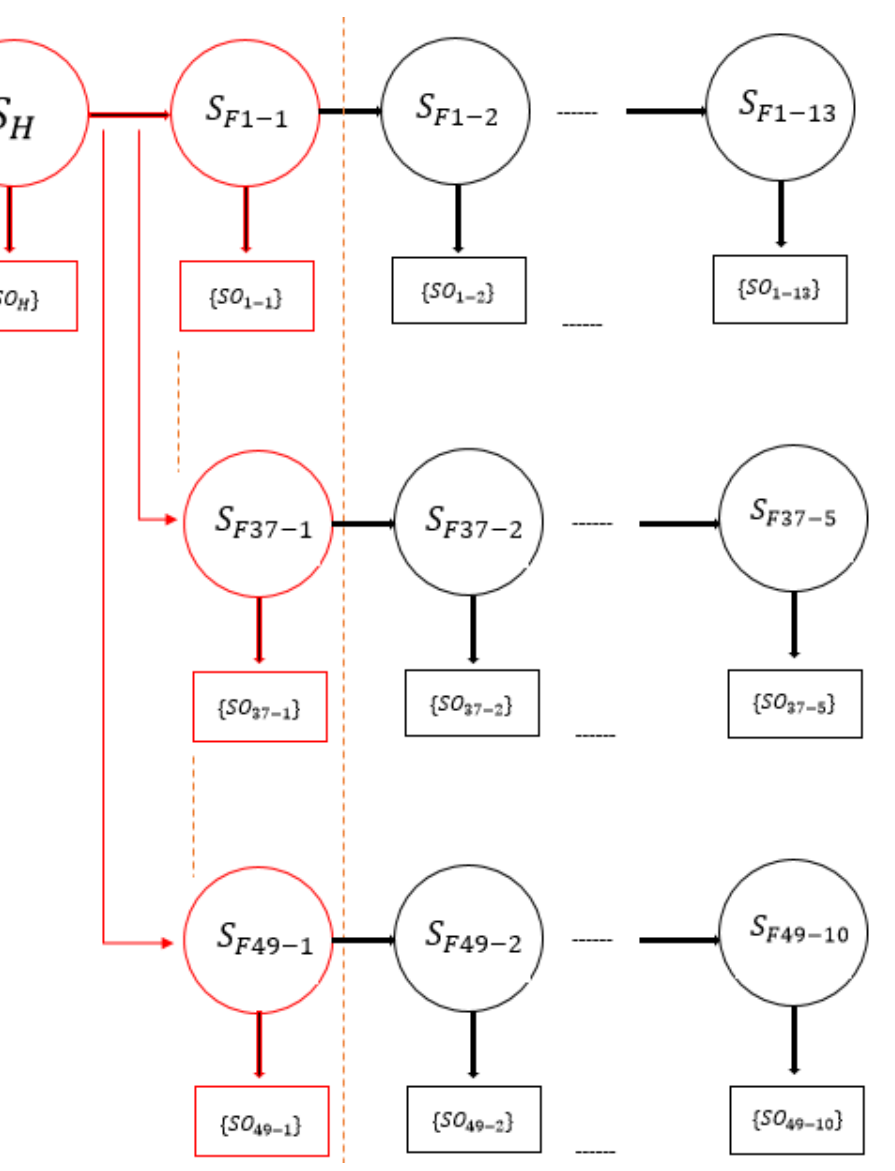
Figure 20. Multi-level trellis diagram.